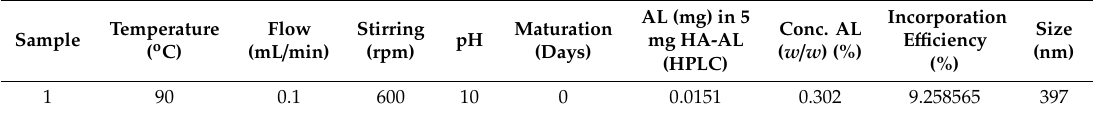
Table 1. Experimental parameters for the HA-AL 20 mM synthesis and the quantity of alendronate contained in the HA-AL composite.